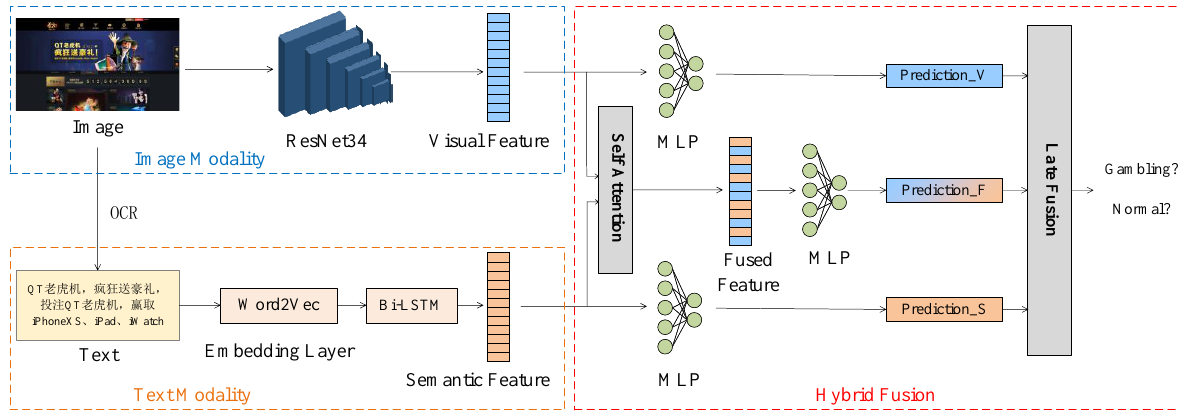
Figure 2. Overview framework of the proposed